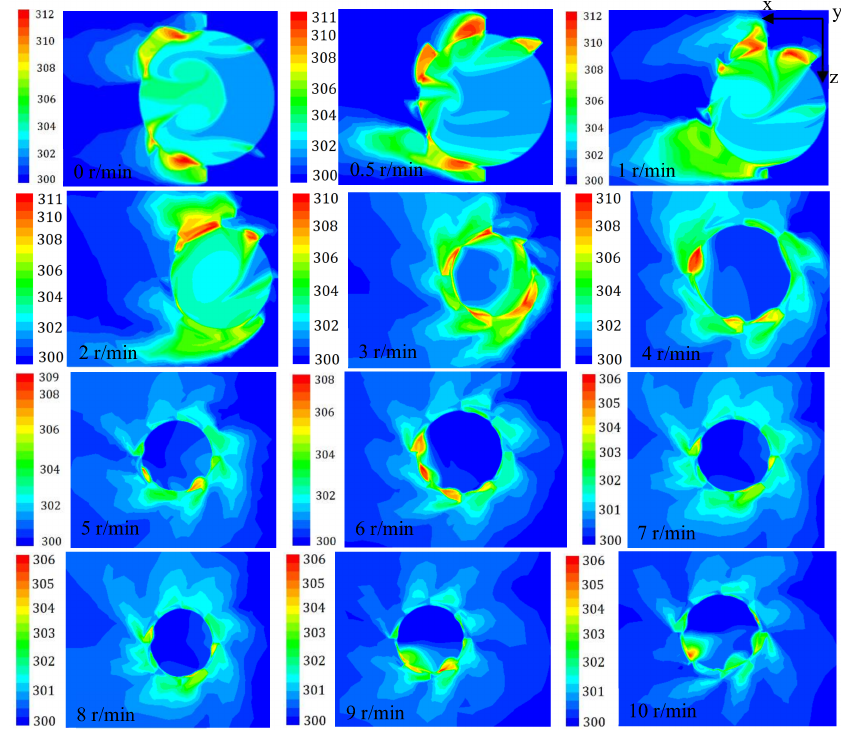
Figure 19. Temperature contours (unit: K) at the inlet of tower with various rotating velocity for wind deflectors under 5 m/s wind speed.